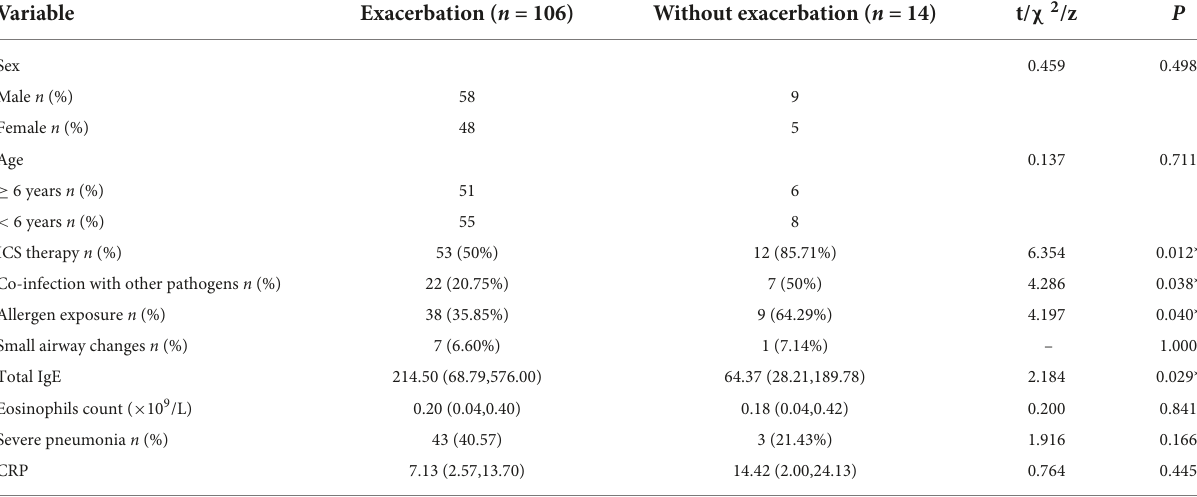
TABLE 3 Basic and clinical characteristics of the children with MPP with asthma exacerbation.